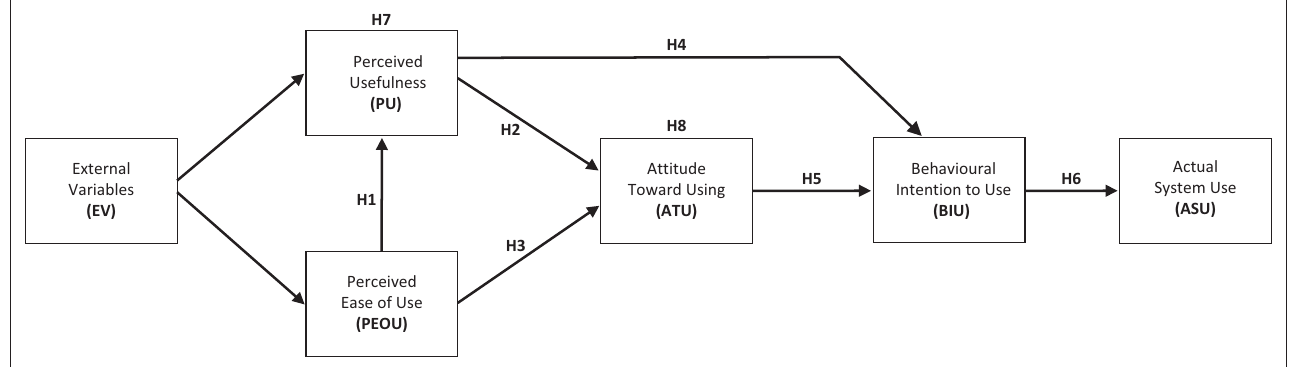
FIGURE 2: Internal relations between technology acceptance constructs.